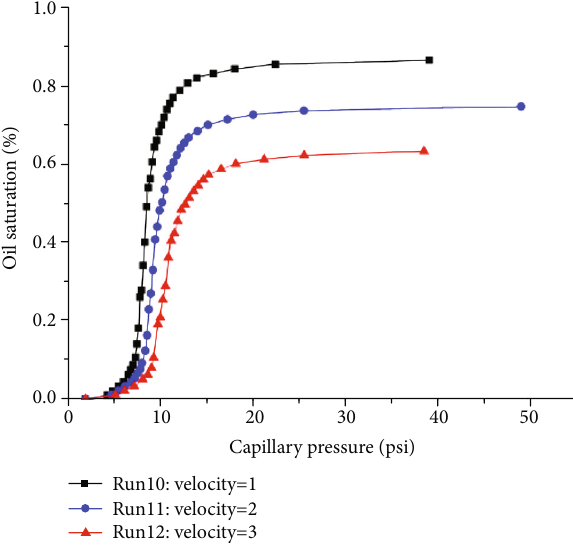
Figure 10: E ff ect of aspect ratio on oil charging curves.